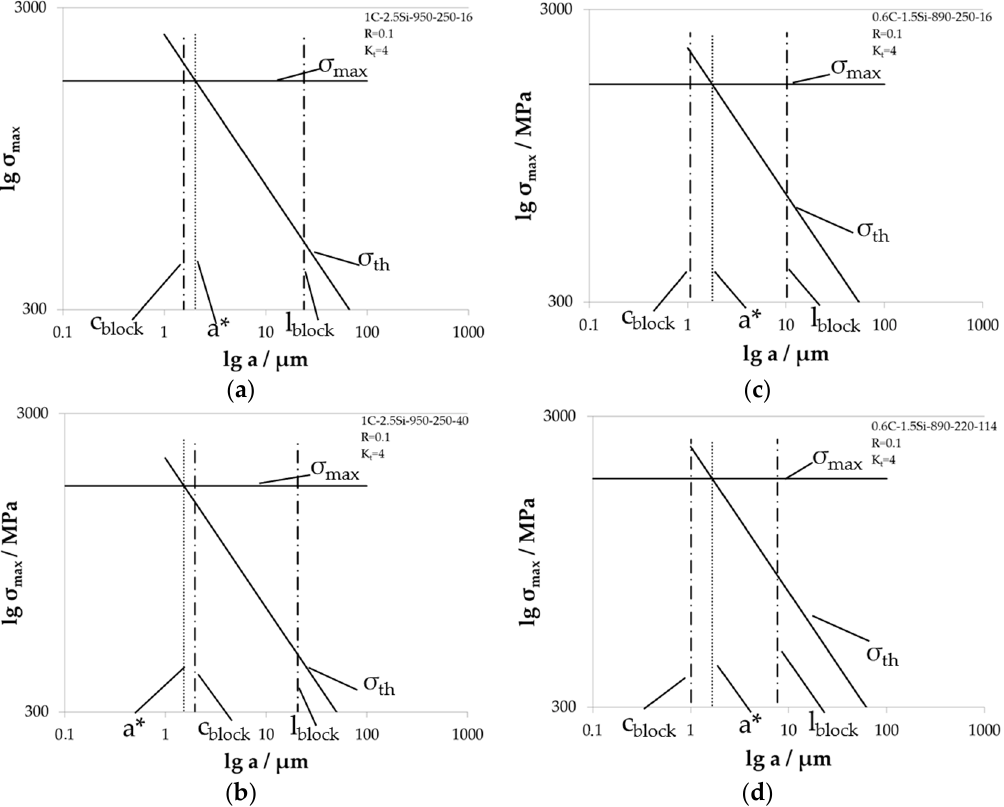
Figure 15. Individual Kitagawa diagrams for material states tested with load ratio R = 0.1 at notched specimens with K t = 4 for ( a ) 1C-2.5Si-950-250-16; ( b ) 1C-2.5Si-950-250-40; ( c ) 06C-1.5Si-890-250-16; and ( d ) 0.6C-1.5Si-890-220-114.